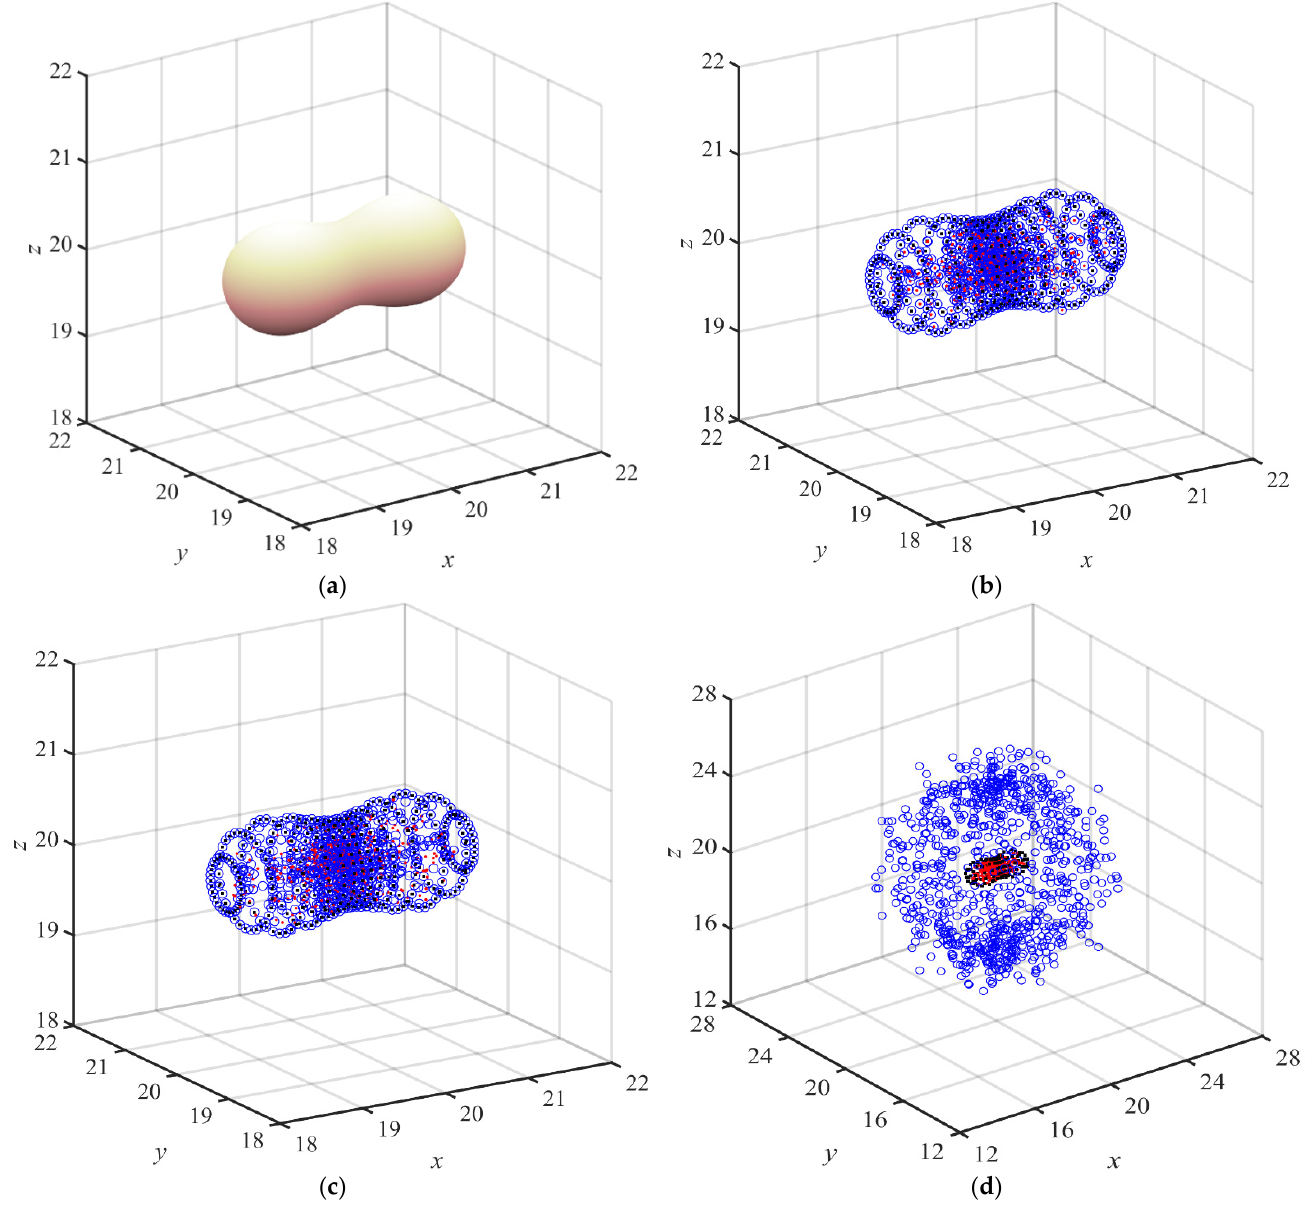
Figure 4. Problem domain and location of the fictitious sources for example 2. ( a ) Problem domain. ( b ) Type A. ( c ) Type B. ( d ) Type C (blue and red circles denote the source and interior points, re- spectively).